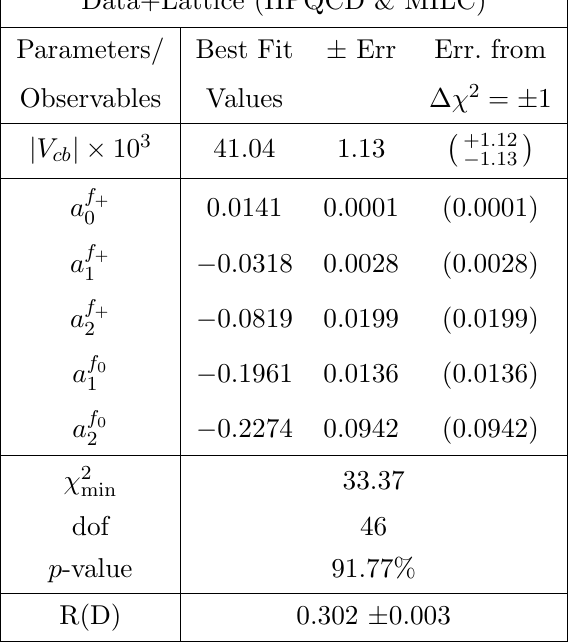
Table 9 . The (cid:12)t results obtained from the analysis of the decay B ! D‘(cid:23) ‘ with the BGL param- eterization of the form factors for N =